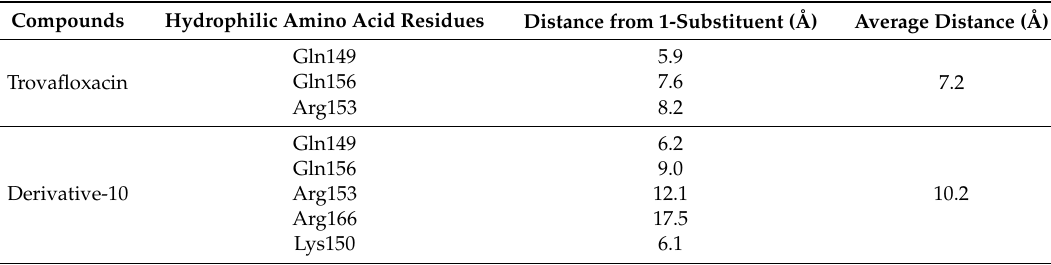
Figure 5. Binding conformation of trovafloxacin and derivative-10 with plasma protein ligand in binding domain.